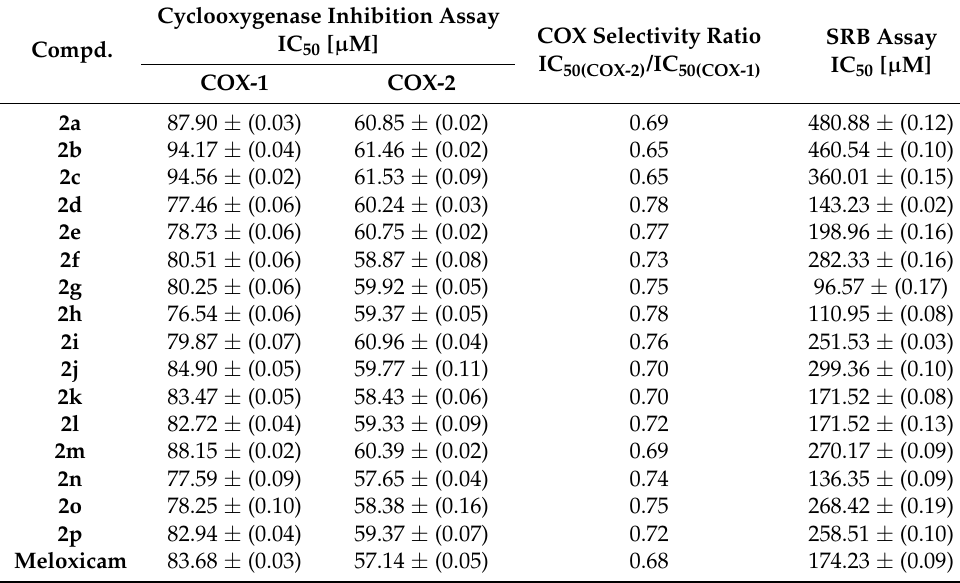
Table 2. COX inhibition calculated for COX-1 and COX-2 enzymes after incubation for 2 min with the tested compounds at a concentration of 100 µ M and COX selectivity ratio; SRB assay—IC 50 values calculated for all tested compounds; data are presented as mean